Question: State the chart type depicted above.
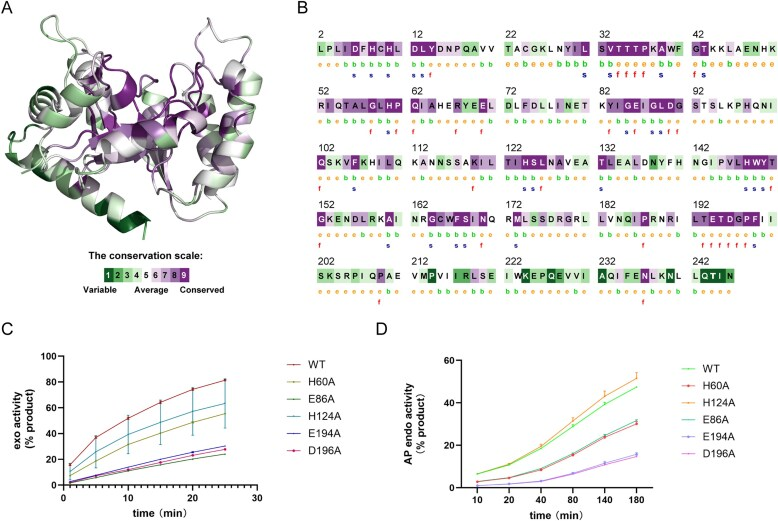
Answer: bar